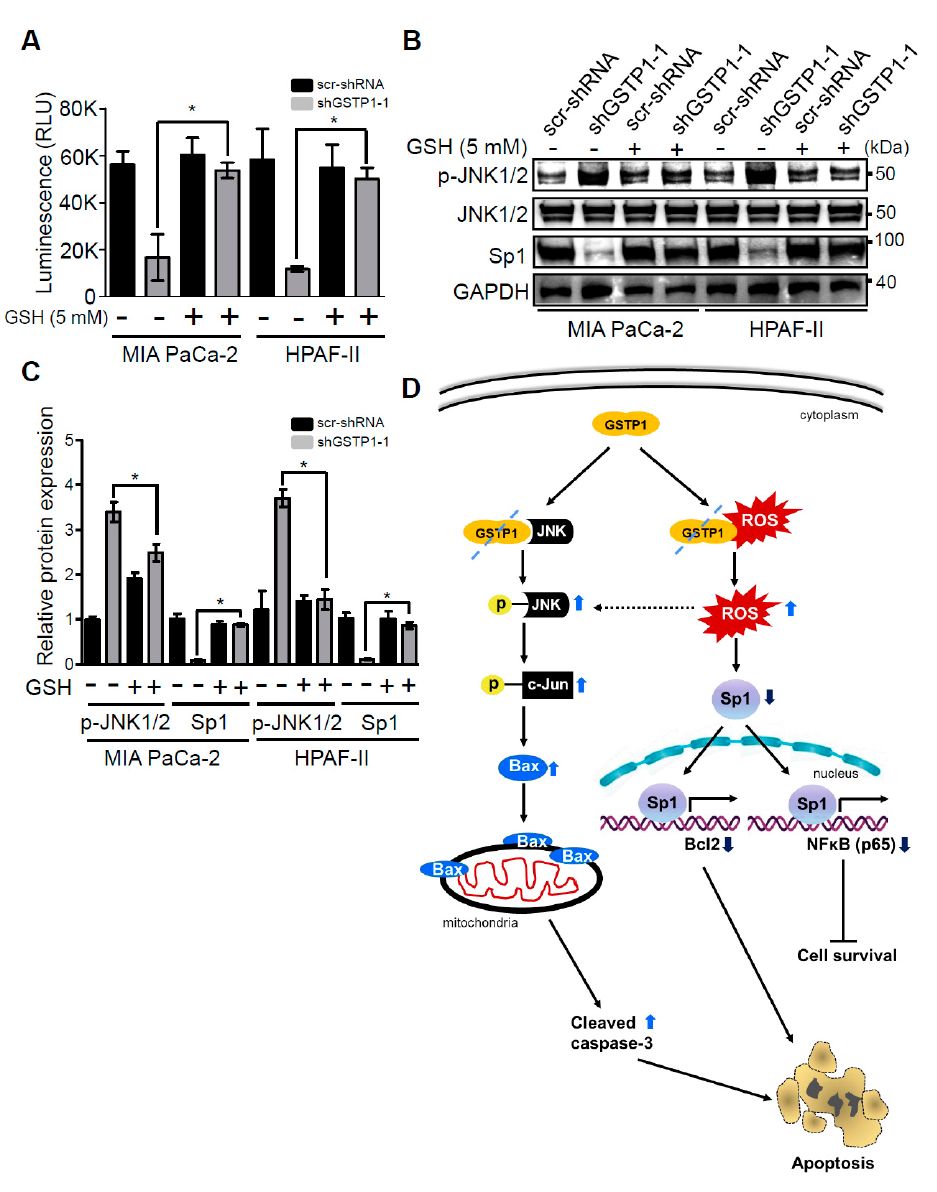
Figure 5. Exogenous antioxidant rescues the cytotoxic e ff ects of GSTP1 knockdown in PDAC cells. Control and GSTP1 knockdown MIA PaCa-2 and HPAF-II cells were treated with 5 mM GSH for 72 h. ( A ) CellTiter-Glo ® assays were used to evaluate the average cell viability for three independent experiments with eight technical replicates for each. The luminescence (cell viability) was compared between shGSTP1-1 with and without GSH treatment. Student’s t-test was used to identify significant di ff erences in growth in GSTP1 knockdown cells treated with or without GSH. RLU: relative luminescence units ( B ) E ff ects of GSH treatment on the phosphorylation of JNK1 / 2 and expression of Sp1 were determined using Western blotting. Total JNK and GAPDH were used as loading controls for the experiment. The figure shows one representative image of three independent experiments. Similar results were obtained in duplicate experiments. ( C ) Protein expression in two independent experiments was quantified using densitometry. p-JNK1 / 2 and Sp1 protein expression levels were compared between shGSTP1-1 with and without GSH treatment. Student’s t-test was used to identify the significant di ff erences in protein expression in the GSTP1 knockdown cells treated with or without GSH. ( D ) Proposed mechanisms underlying the role of GSTP1 in pancreatic cancer cell proliferation, survival, and apoptosis based on Western blotting and qRT-PCR data. For all figures, * denotes statistically significant di ff erences ( p < 0.05). Unprocessed images for the Western blotting results are shown in Figure